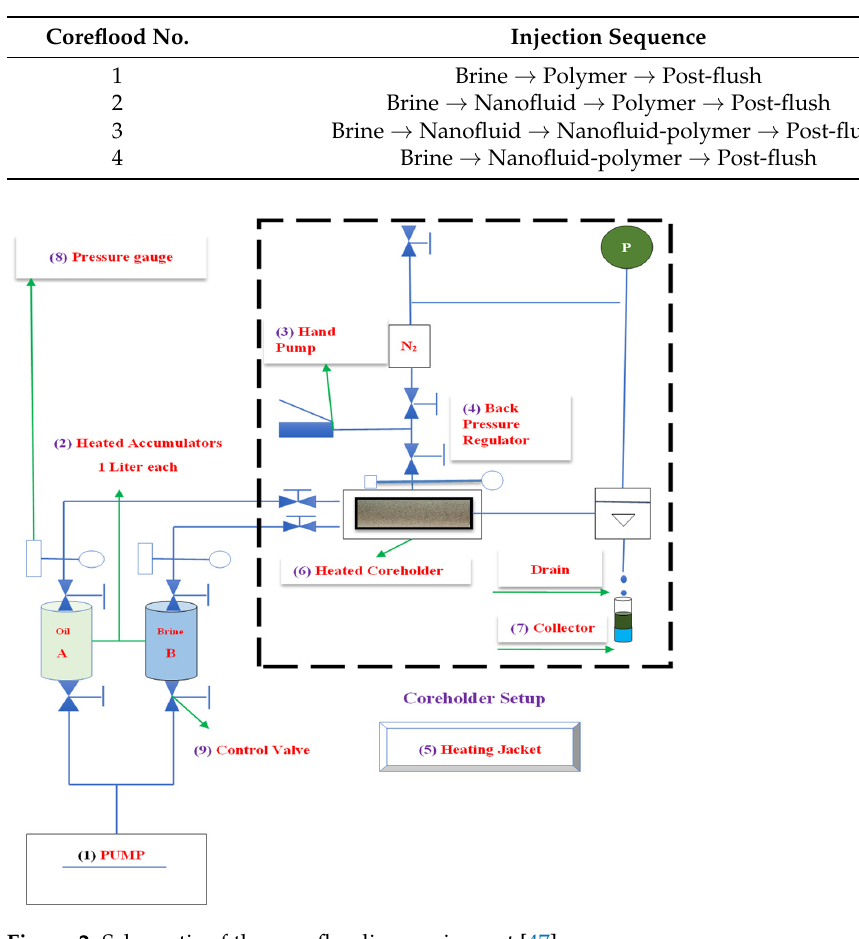
Figure 2. Schematic of the core flooding equipment [47].